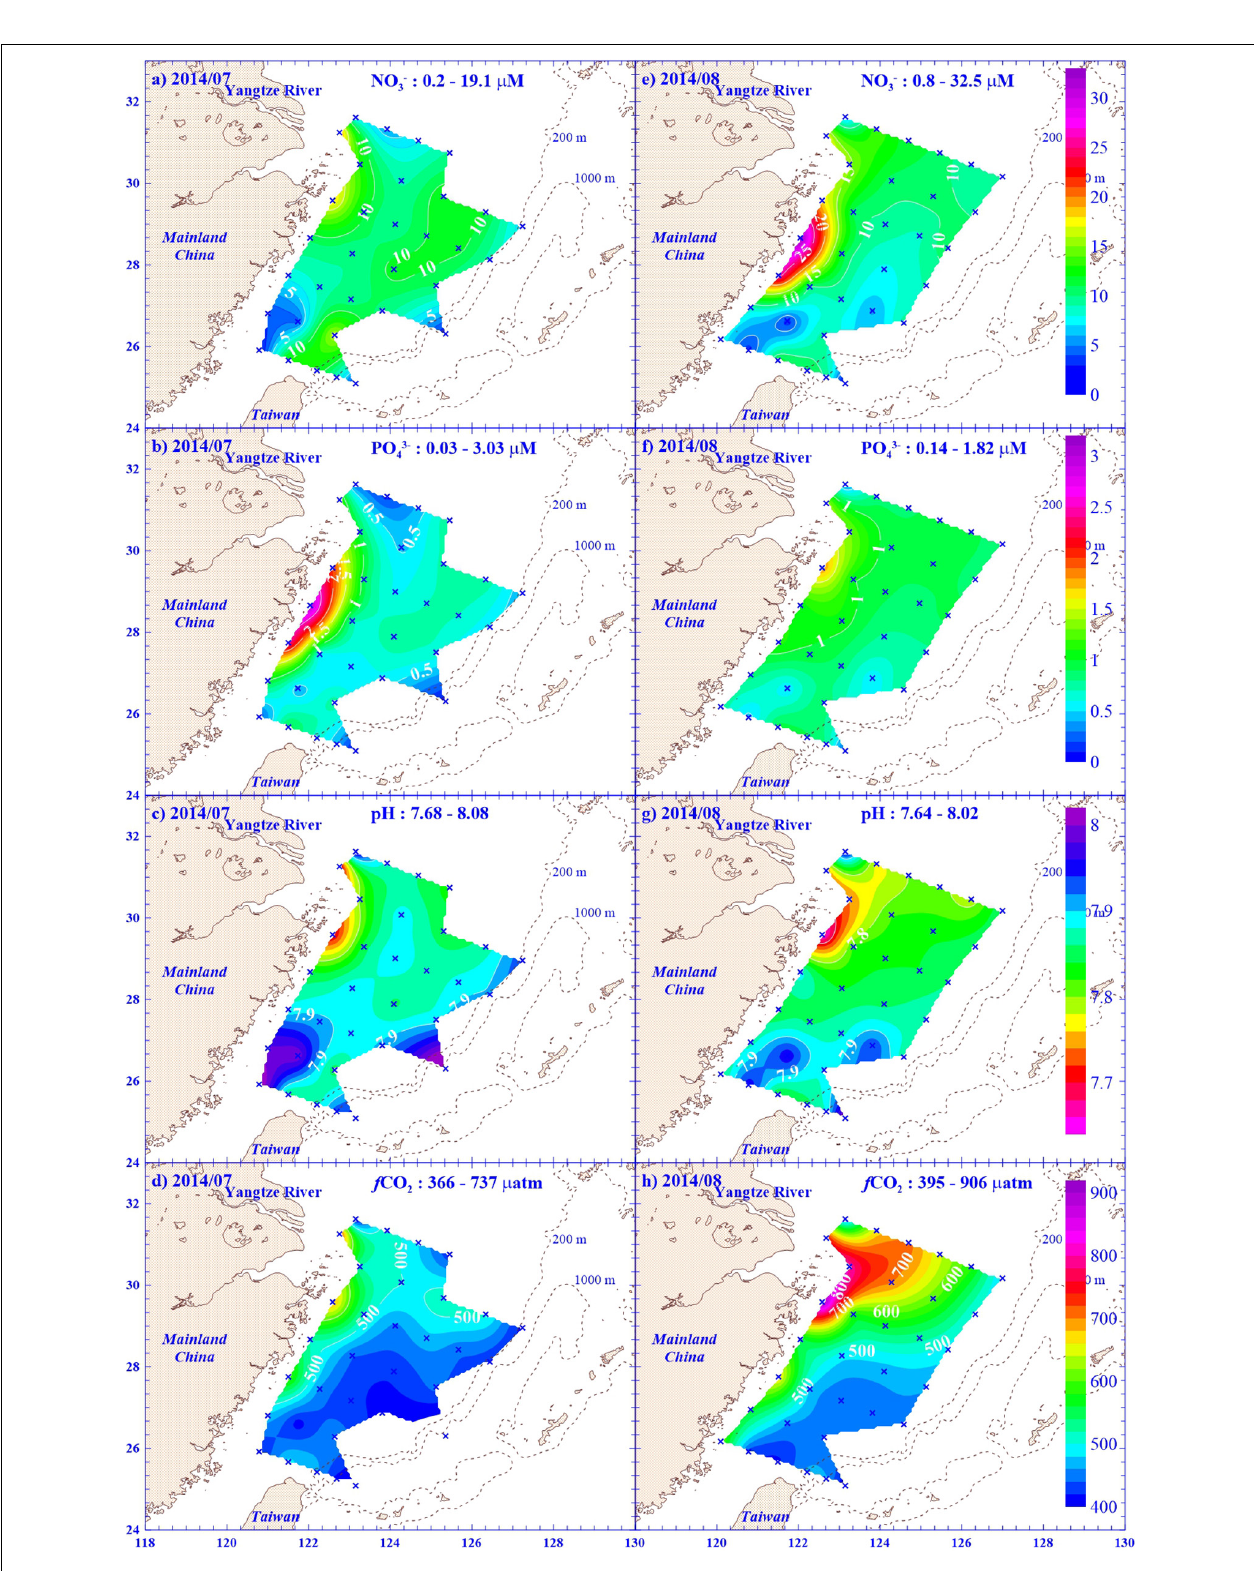
FIGURE 3 | Contours of different variables, including nitrate (NO 3 − ), phosphate (PO 43 − ), pH, and fugacity of CO 2 ( f CO 2 ), in bottom water column or at 100 m if water column depth was > 100 m in East China Sea in (a–d) July and (e–h) August 2014. The range of variables are also displayed at the top of each panel. Color codes for the values of each variable are given in the left